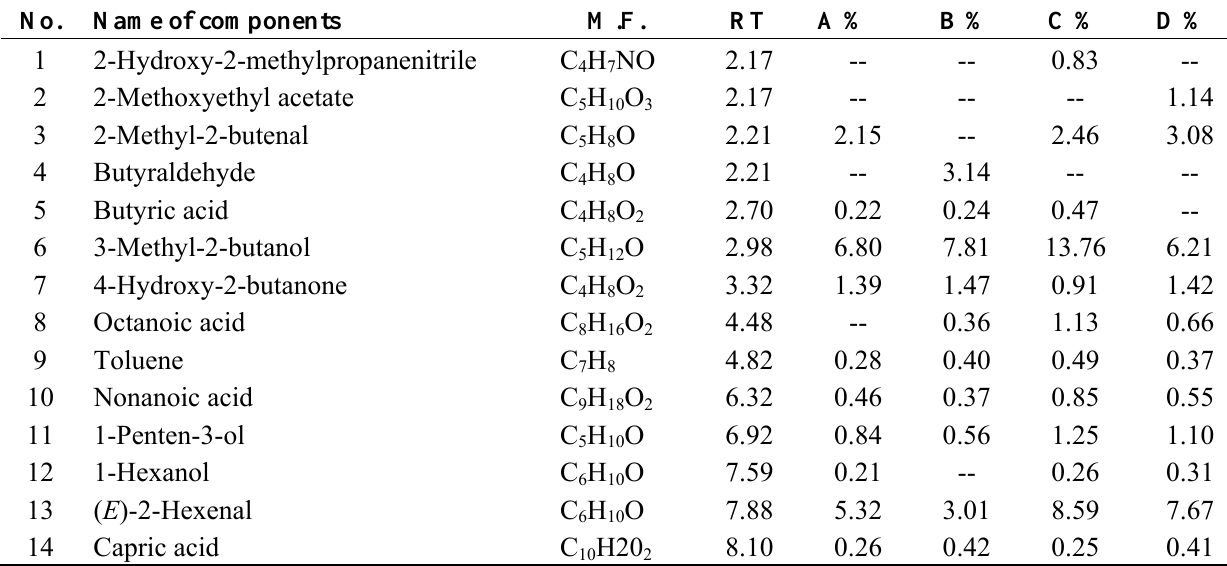
Table 1. Chemical composition of the essential oils of the four